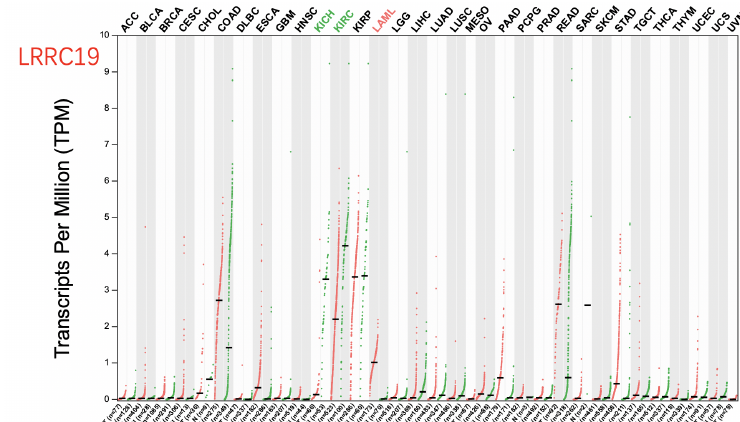
Figure A3. Dot plot profiling LRRC19 expression across 33 cancer types of TCGA and paired normal samples, with each dot representing a distinct tumor or normal sample. “TCGA normal + GTEx normal” were selected for matched normal data in plotting. The custom fold-change threshold was set as | log ( TPM + 1 ) pre-transformed. FC | > 1 and adjust . p -value < 0.01, and the expression data were log 2 2 Each dot represents a distinct tumor (pink) or normal sample (green). The abscissa represents the sample from tumor tissue (T) or normal tissue (N), and “n” equals the sample size. The ordinate represents the amount of transcript expression in the sample. Above the table were the TCGA abbreviations of the cancer name. The cancer name coding in green indicated that the target gene was relatively lower expressed in the tumor tissue, and the red indicates higher expression. We selected LIMMA as the FC | > 1 and FDR < 0.01 were considered as differentially differential method. |log 2